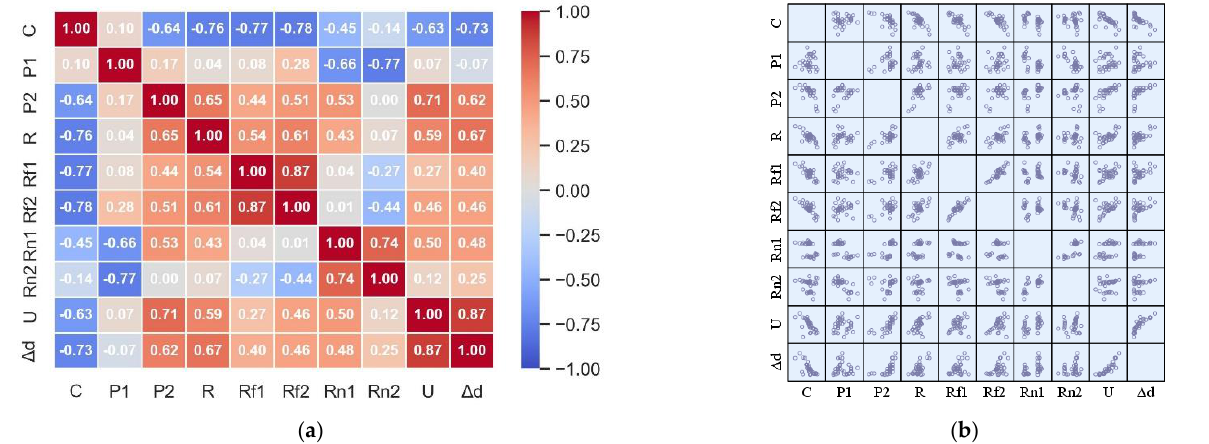
Figure 4. ( a ) Heatmap of correlation between parameters; ( b ) scatter distribution map between pa-